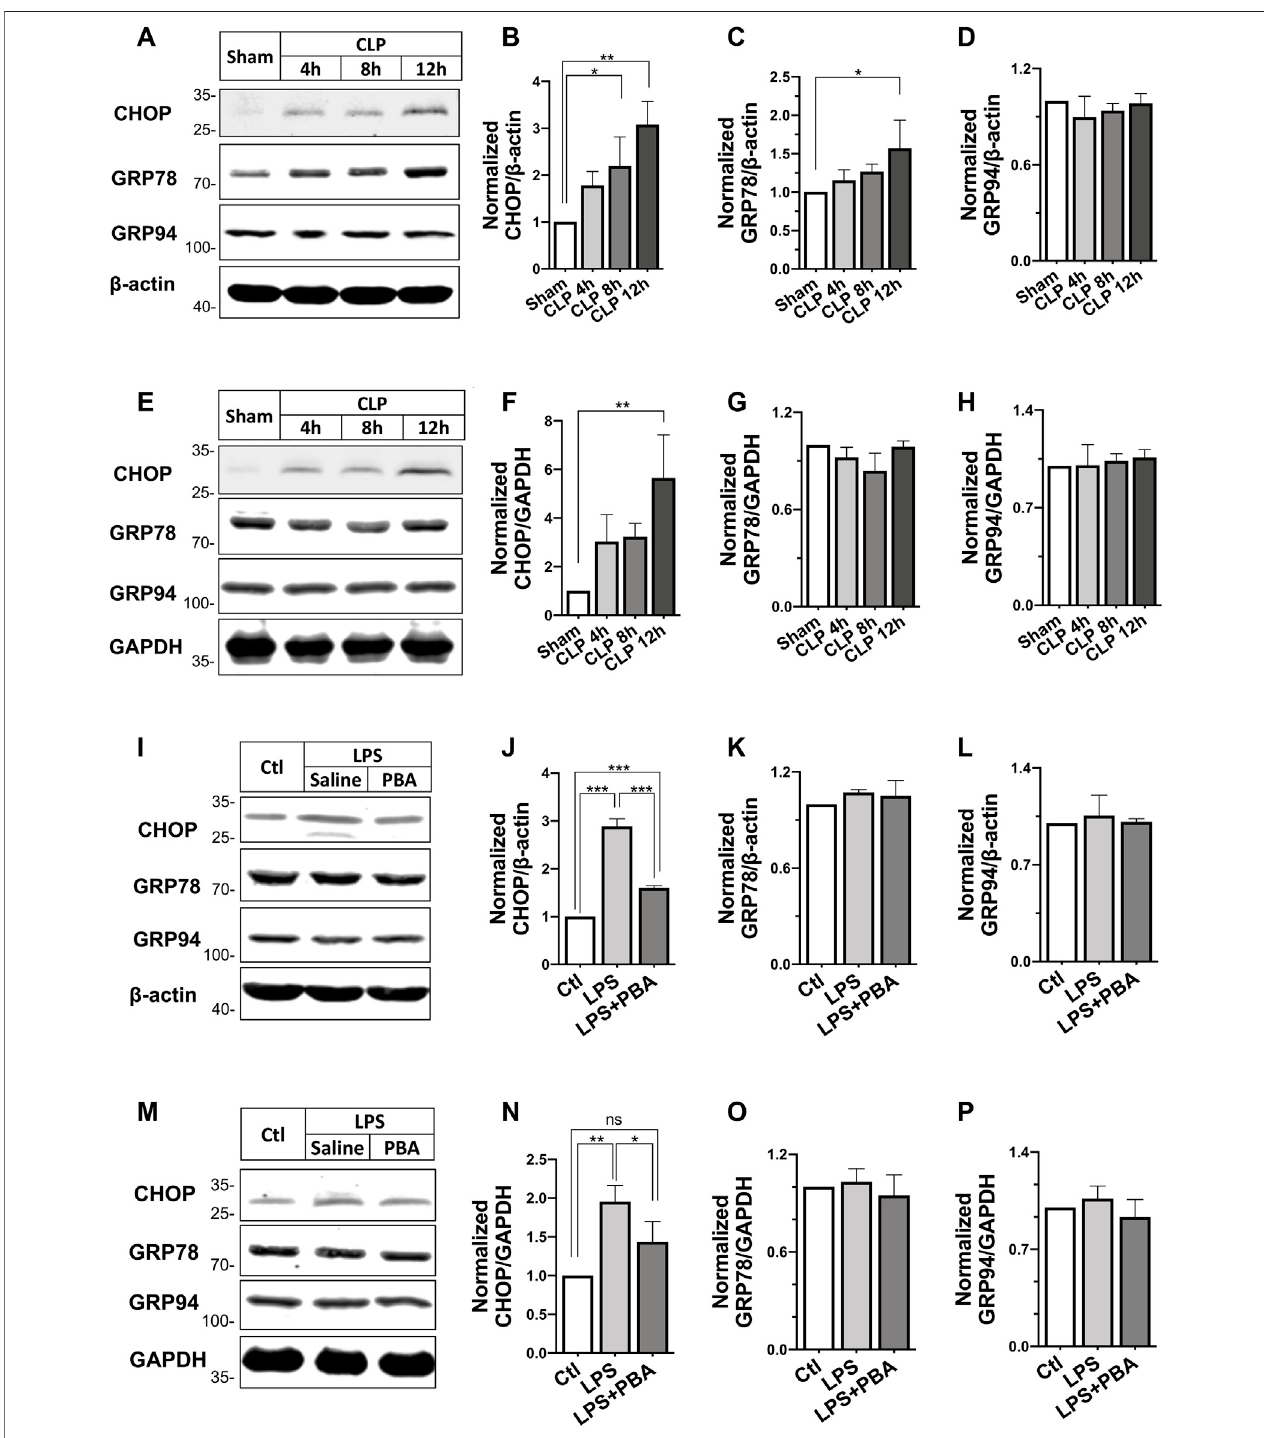
FIGURE 5 | Effects of PBA on ERS-related protein expression after septic shock in rats. (A – D) , Changes in expression of C/EBP homologous protein (CHOP), glucose-regulated protein 78 (GRP78), glucose-regulated protein 94 (GRP94) in the superior mesenteric artery after different times of CLP ( n (cid:1) 3); (E – H) , Changes in expression ofC/EBPhomologousprotein (CHOP),glucose-regulated protein78(GRP78),glucose-regulatedprotein 94(GRP94) intheheartafter differenttimesofCLP ( n (cid:1) 3); (I – L) ,effectsofanti-ERSwithPBAontheexpressionofCHOP,GRP78,andGRP94inLPS-challengedVSMCs; (M – P) ,effectsofanti-ERSwithPBAonthe expression of CHOP, GRP78 and GRP94 in LPS-challenged H9C2 cardiomyocytes ( n (cid:1) 3). CLP, cecal ligation and puncture; CsA, cyclosporine A; PBA, 4- phenylbutyrate acid; ** p < 0.01, *** p < 0.001; ns , not signi fi cant.